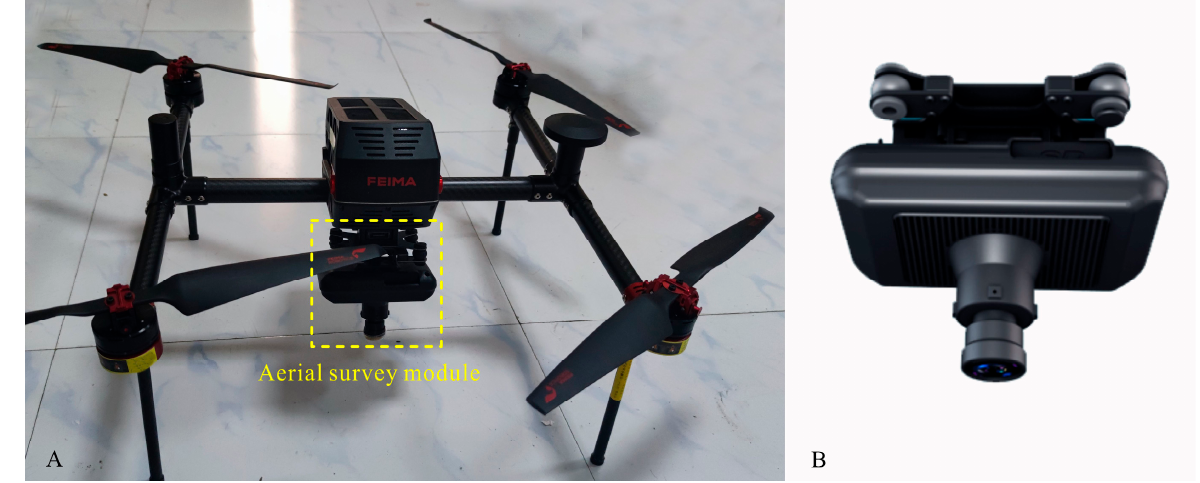
Figure 6. ( A ): E2000S Pegasus UAV used in this study; ( B ): Aerial survey module E-CAM2000.